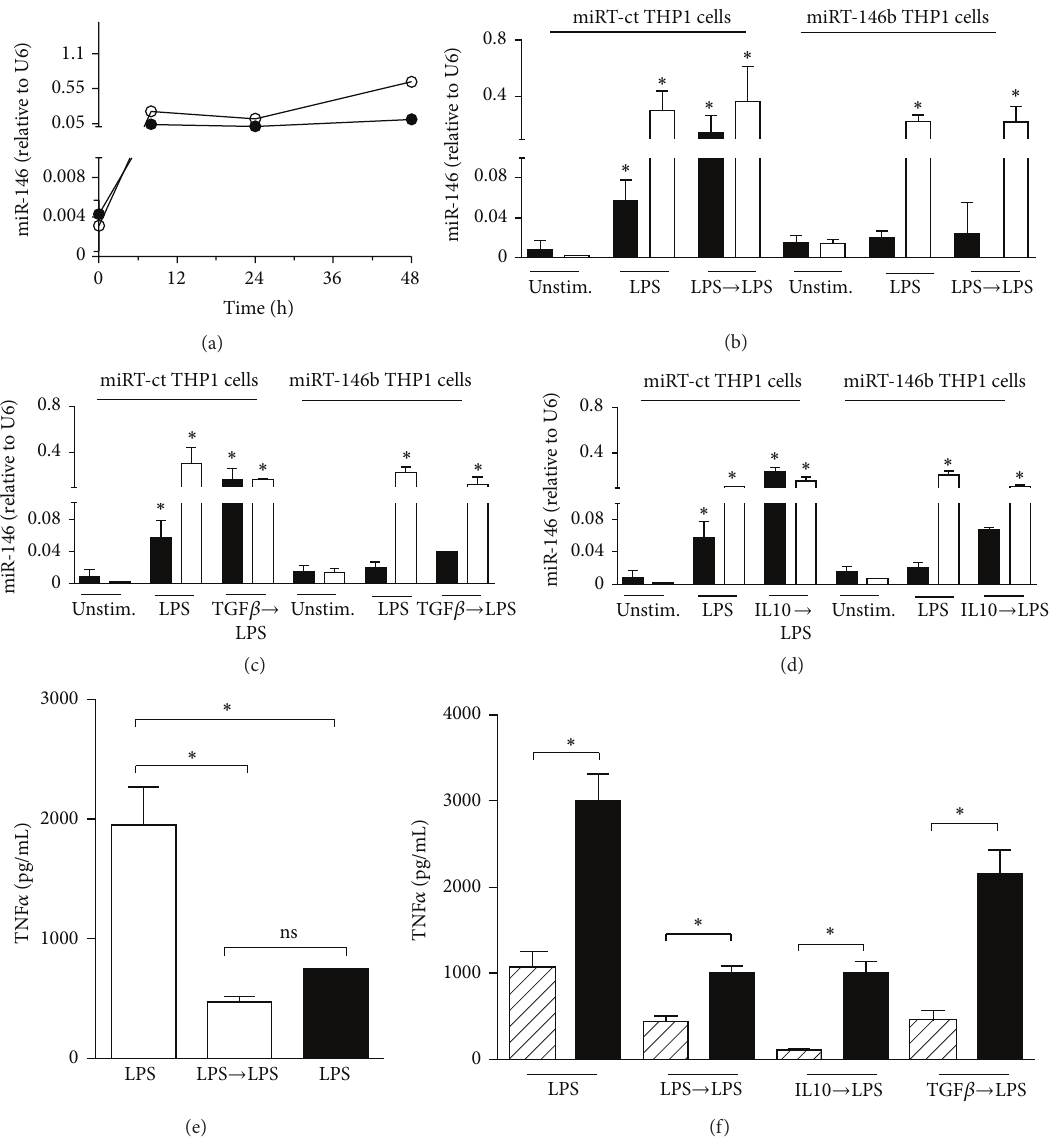
Figure 5: (a) THP-1 wild-type cells were stimulated for the indicated times with 1 𝜇 g/mL of LPS. MiR-146b (black circles) and miR-146a (white circles) were measured by qPCR and their levels were normalized relative to U6. (b-d) miRT-ct and miRT-146b THP-1 cells were primed or not with 100ng/mL LPS (b), 20 ng/mL IL-10 (c), or 50 ng/mL TGF 𝛽 (d) for 18h and then challenged with 1ug/mL LPS for 24 h. MiR-146b (black columns) and miR-146a (white columns) were measured by qPCR and normalized to U6 levels. (e) TNF 𝛼 protein levels were measured by ELISA in cell-free supernatants of pRRL-ct (white columns) or pRRL-146b (black columns) THP-1 cells primed or not with 100 ng/ml LPS and stimulated with 1 ug/mL LPS. (f) miRT-ct (white columns) and miRT-146b (black columns) THP-1 cells were primed or not with 100ng/mL LPS, 20 ng/mL IL-10, or 50 ng/mL TGF 𝛽 for 18h and then challenged with 1ug/mL LPS for 24h. TNF 𝛼 protein levels were quantified by ELISA. Results are expressed as mean ± SEM of three independent